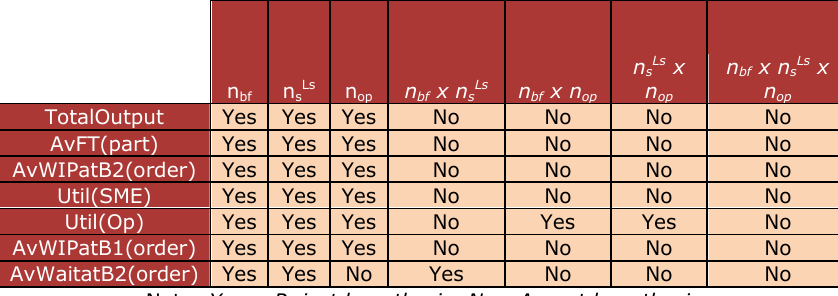
Table 5. Summary of multi-factor ANOVA tables for the push